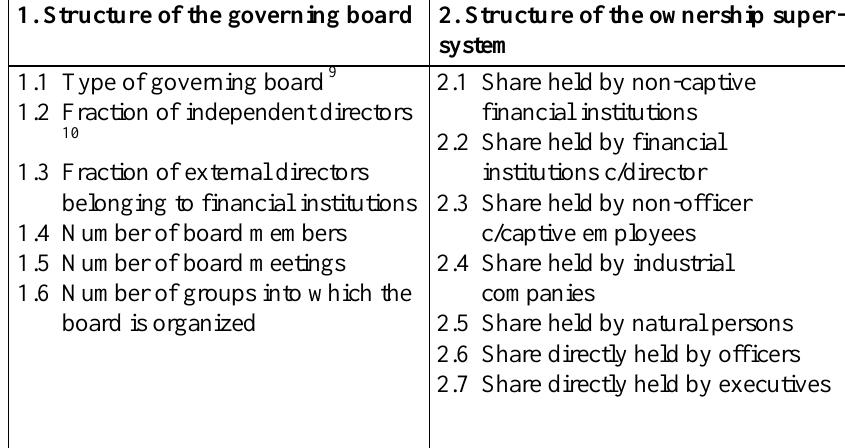
Table 2: The Analysis Variables 1. Structure of the governing board 2. Structure of the ownership super-